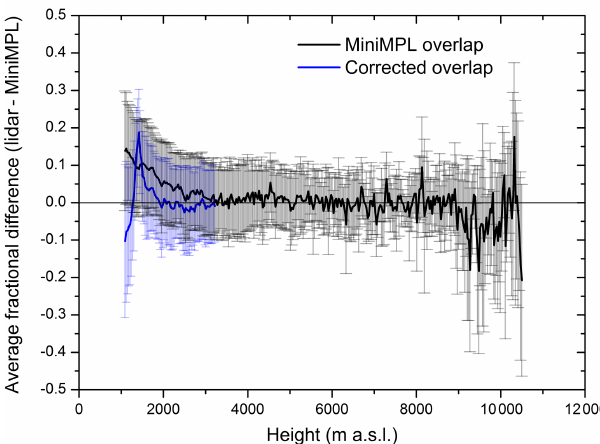
Figure 5. Profiles of the average fractional difference between MUSA and MiniMPL values of RCS calculated on 12 cases of si- multaneous and collocated measurements (black line). Blue line is the same as black line but applying an additional overlap correction factor to the MiniMPL data processing estimated using the ratio between MUSA and MiniMPL profiles during the cleanest simul- taneous measurement session available during INTERACT-II. The vertical bars are the SDs of fractional